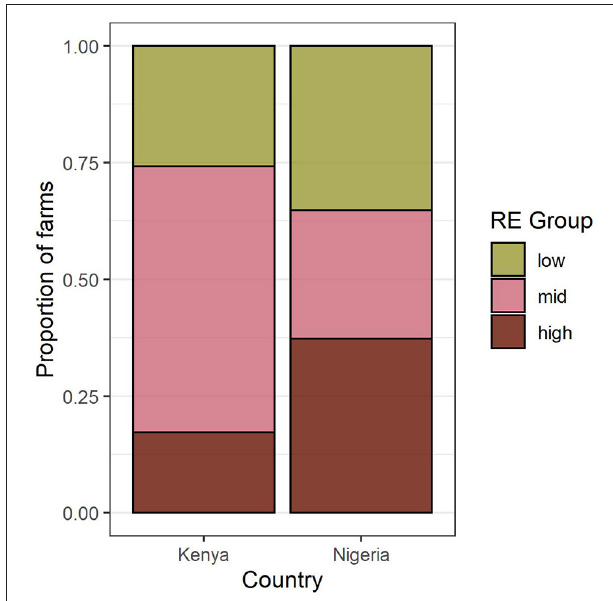
FIGURE 3 | Proportion of farms in each country belonging to each resource endowment (RE) group identified by the cluster